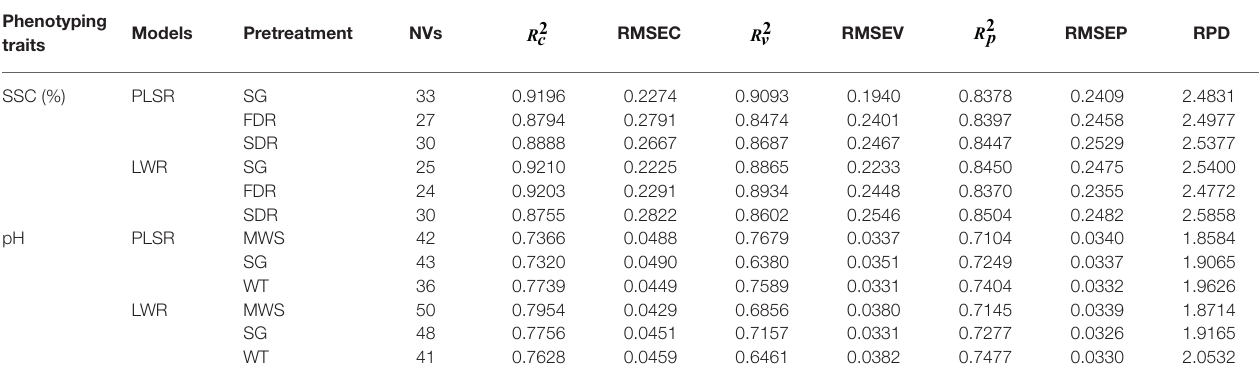
TABLE 5 | Prediction of SSC and pH combining with